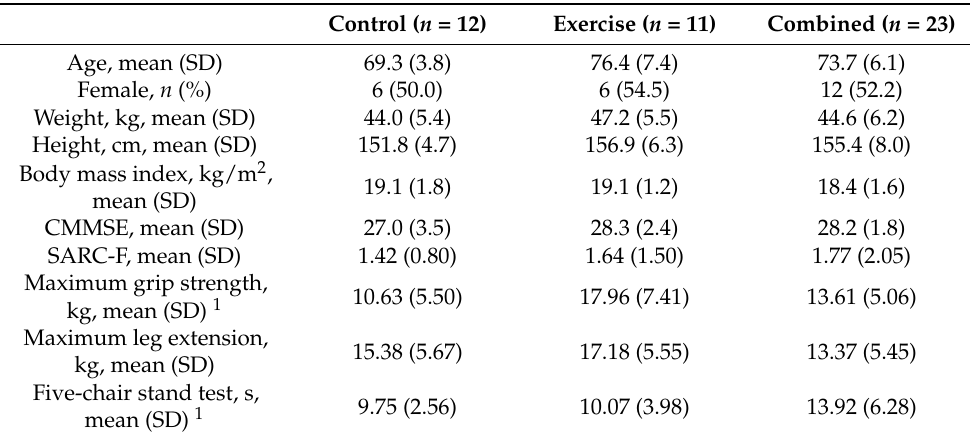
Table 1. Baseline characteristics of the study participants.